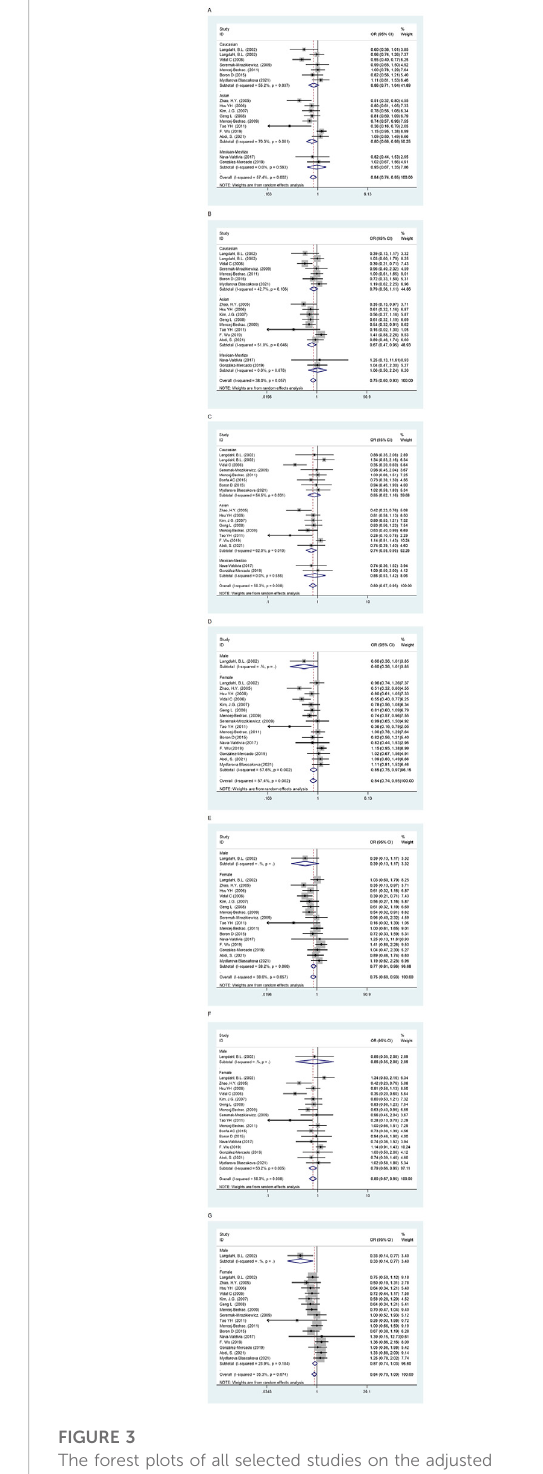
FIGURE 2 The forest plots of all selected studies on the adjusted association between the OPG A163G polymorphism and risk of osteoporosis in overall and subgroup analyses by ethnicity and sex (A:AG+ GGvsAA; (B) AA +GG vsAG; (C) G vs A; (D) AG+ GG vs AA).